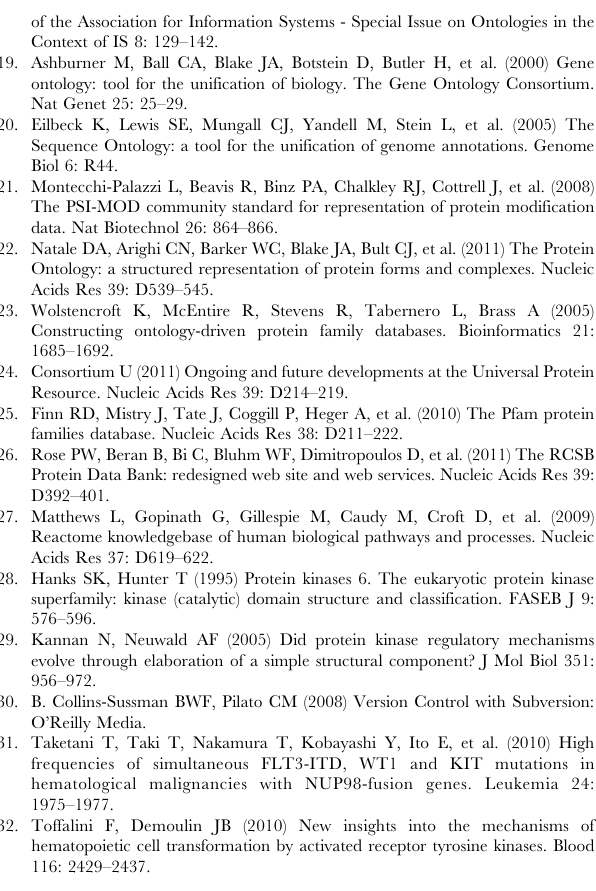
Table S1 Classes (concepts) in ProKinO. Table S2 Object properties used in ProKinO. Table S3 Data properties used in ProKinO.